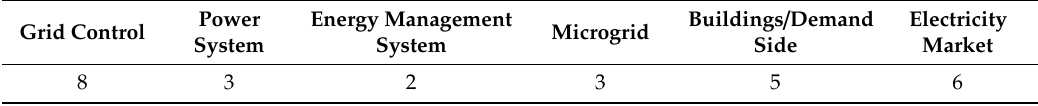
Table 2. Six addressed sub-domains by the selected